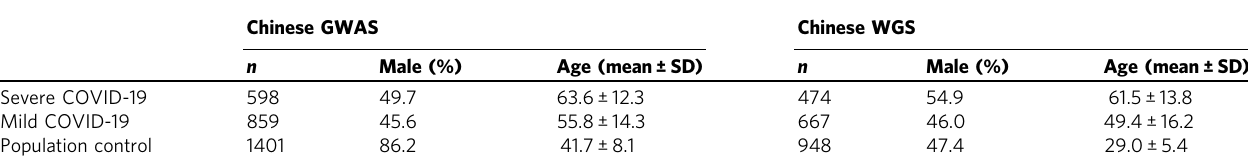
Table 1 Demographic characteristics of Chinese GWAS and WGS